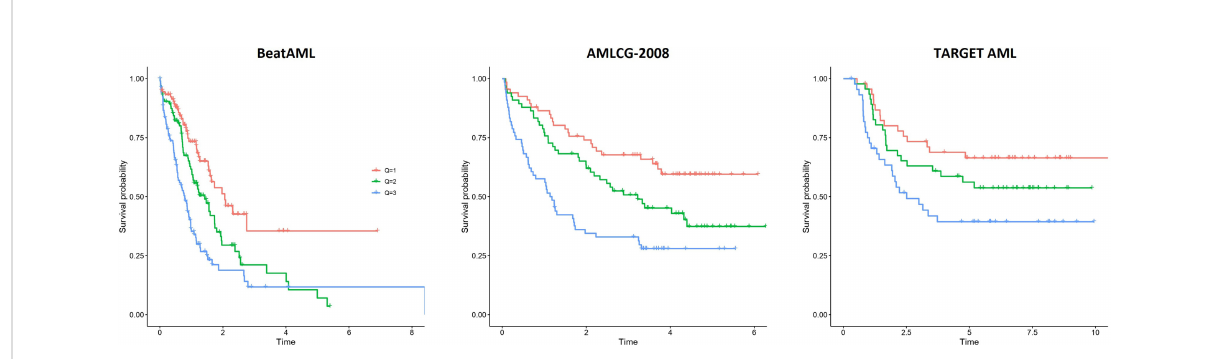
FIGURE 1 Patient survival according to the tertiles of risk predicted by Stellae-123 in the BeatAML, AMLCG-2008 and TARGET AML cohorts.